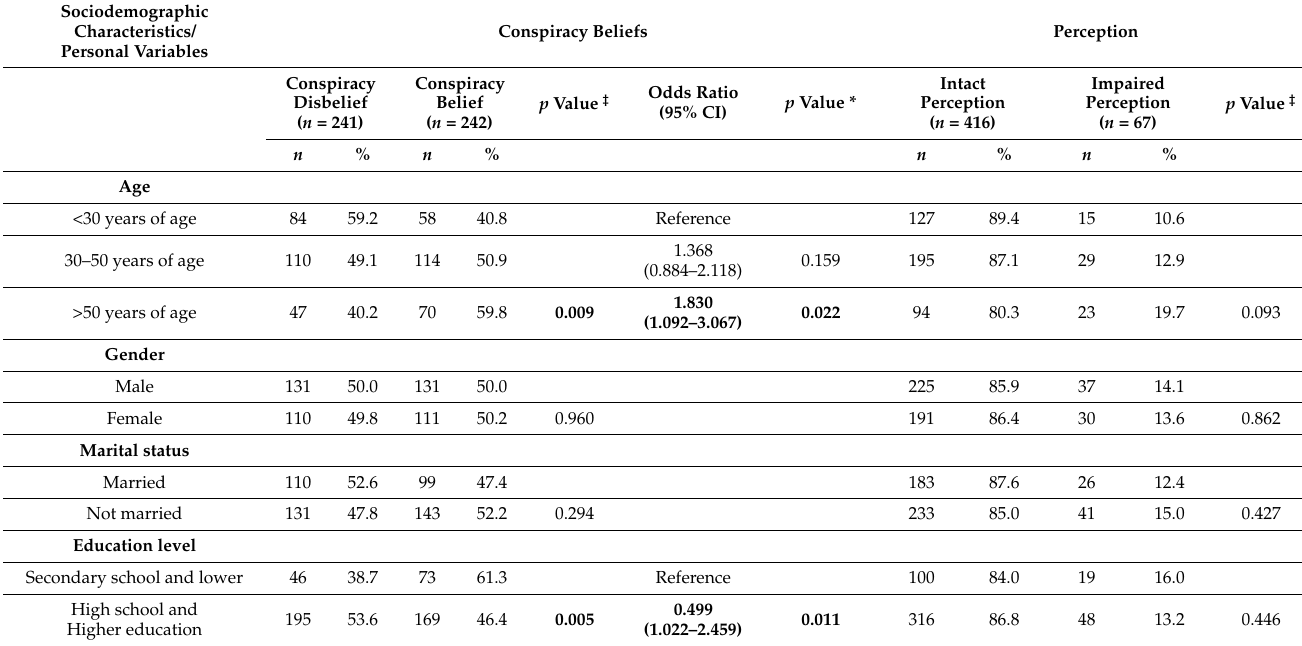
Table 4. The association of COVID-19 perceptions/conspiracy beliefs with personal